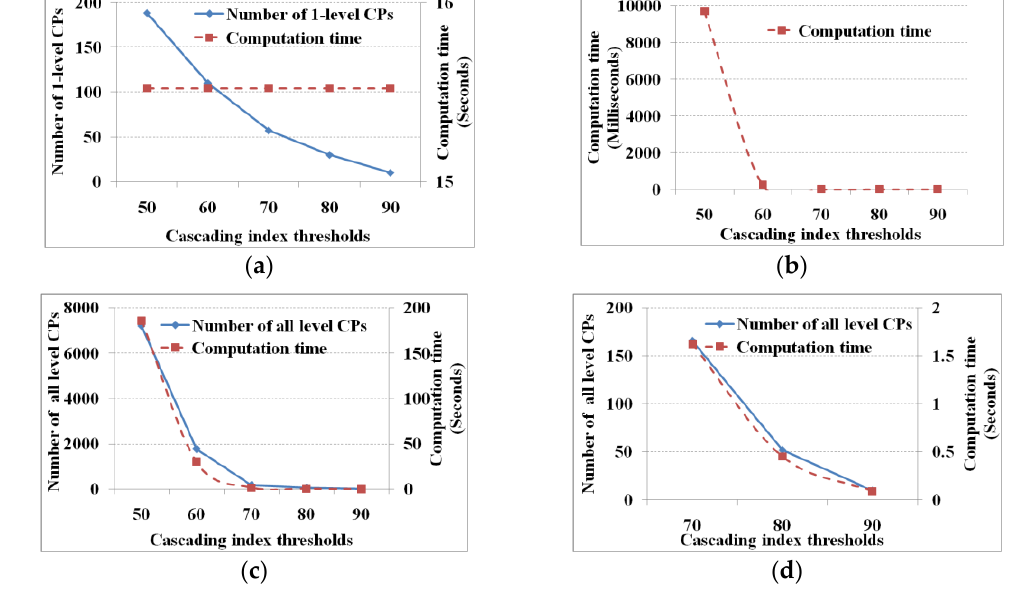
Figure 5. Performance under different cascading index thresholds. ( a ) Number of one-level cascading patterns and computation time; ( b ) Computation time of linking and pruning; ( c ) Total number of cascading patterns and computation time; ( d ) Partial enlargement of ( c ).